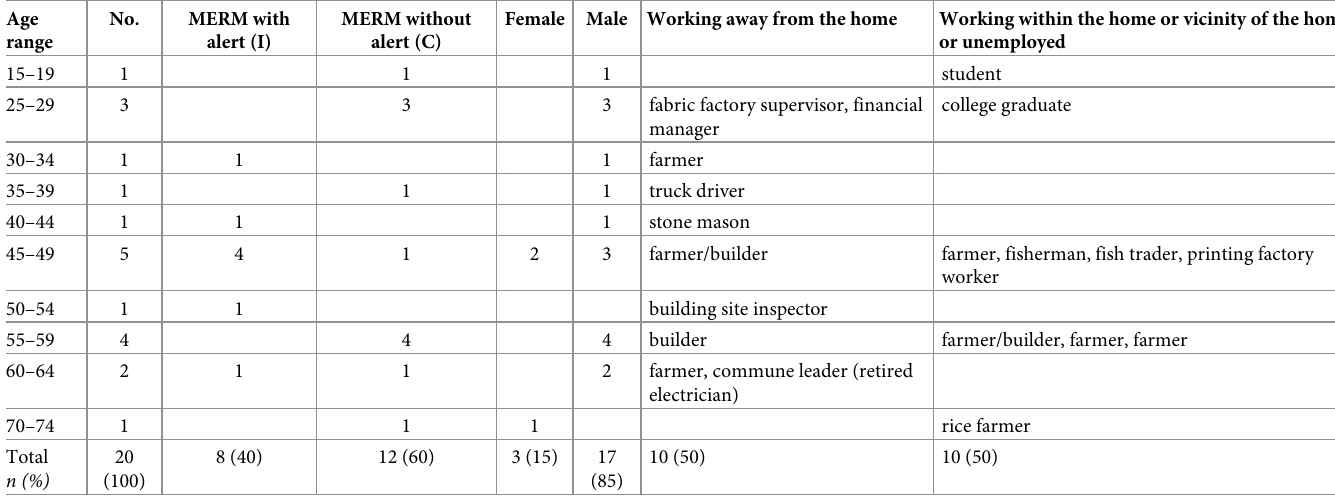
Table 1. Qualitative sample overview n =